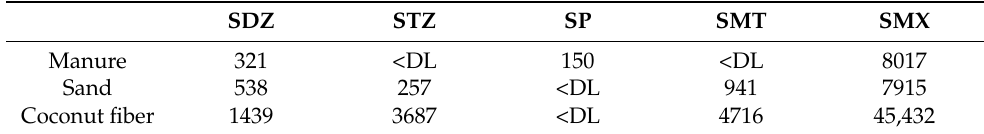
Table 3. Concentration of sulfonamides (sulfadiazine (SDZ), sulfathiazole (STZ), sulfapyridine